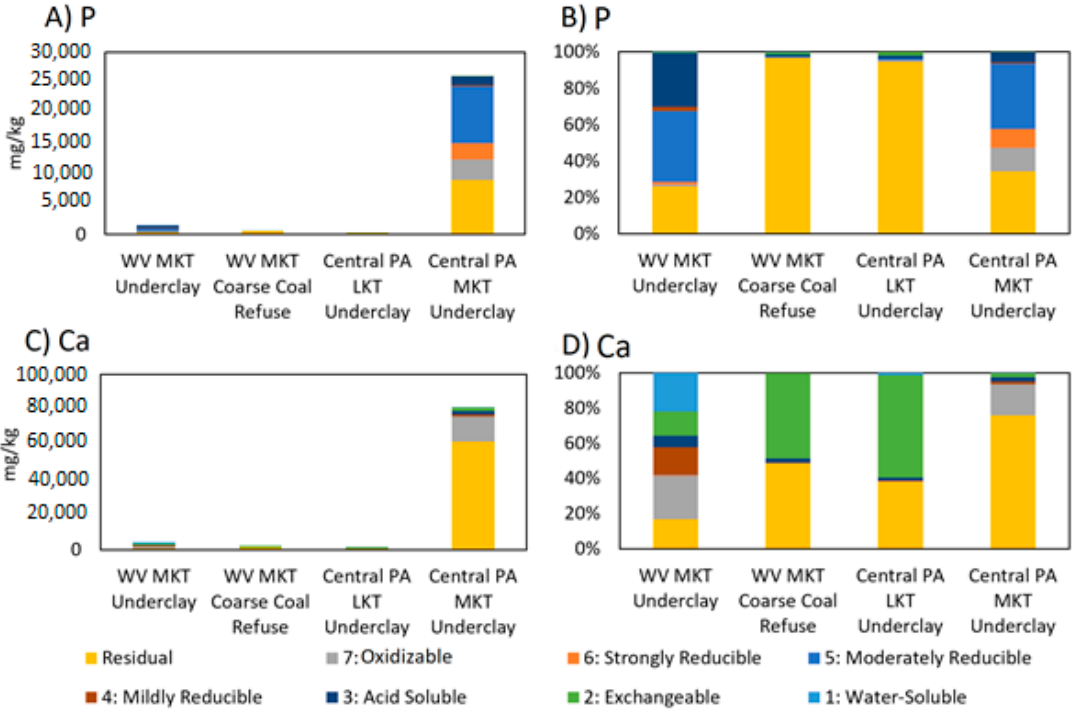
Figure 5. ( A ) Distribution of P from sequential extractions. ( B ) Plot of P distribution from sequential extractions normalized to percentage extraction. ( C ) Distribution of Ca from sequential extractions. ( D ) Plot of Ca distribution from sequential extractions normalized to percentage extraction.